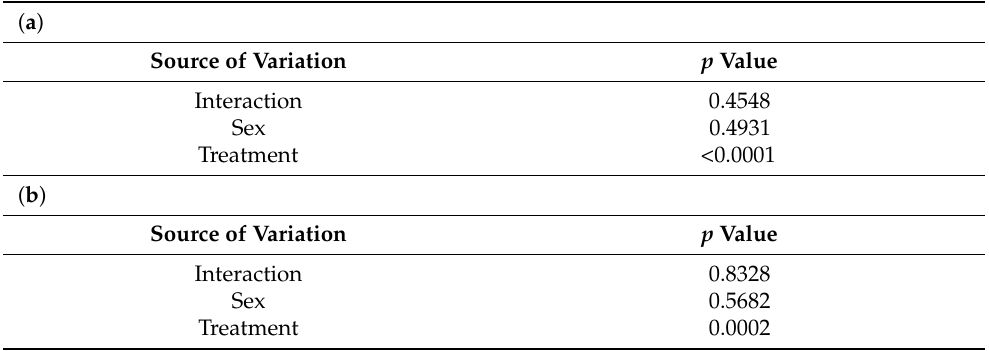
Table 5. ( a ) Statistical table of the individual effects and interactions of rat sex and treatment on cardiac NF- κ B concentration. ( b ) Statistical table of the individual effects and interactions of rat sex and treatment on cardiac TNF- α concentration.